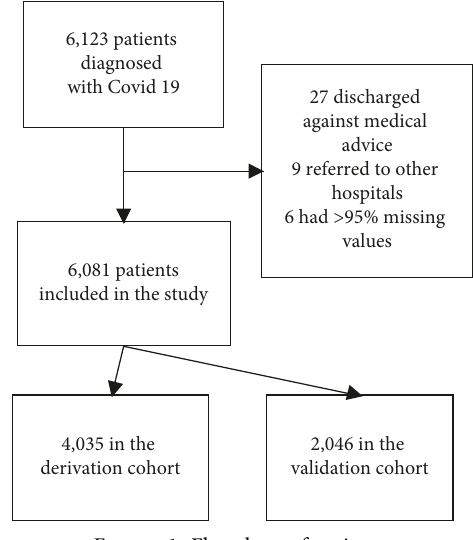
Figure 1: Flowchart of